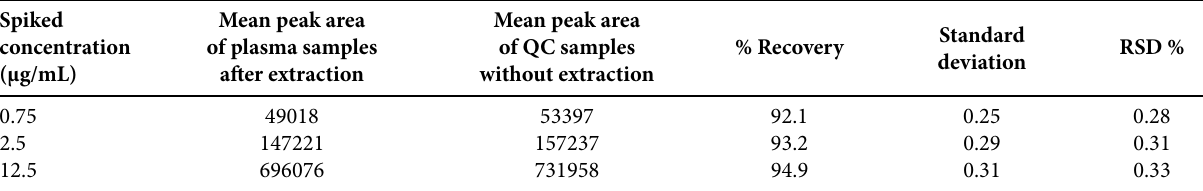
Table 3. Absolute recovery of HPLC method Spiked